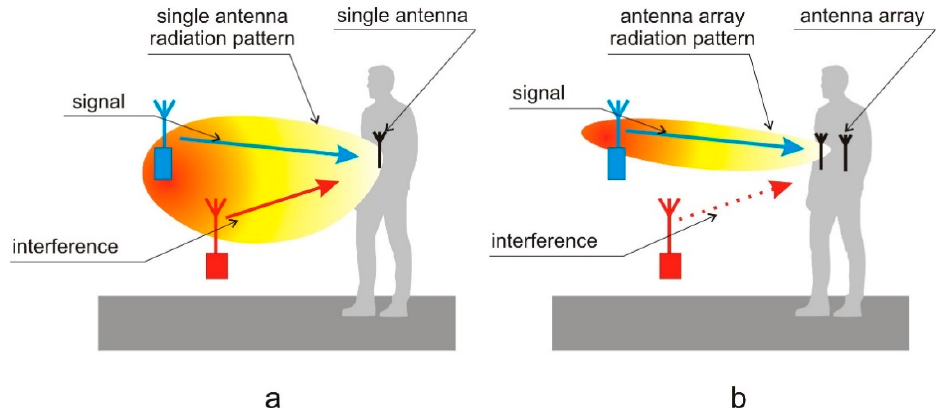
Figure 1. The principle of adaptive array operation for interference rejection: ( a ) single antenna realizes broad radiation pattern; ( b ) antenna array can direct the beam towards the signal.